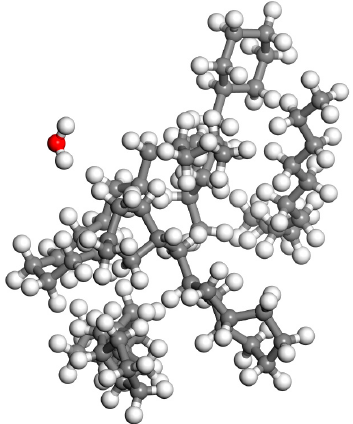
Figure 6. Local region model of an oil-water system.